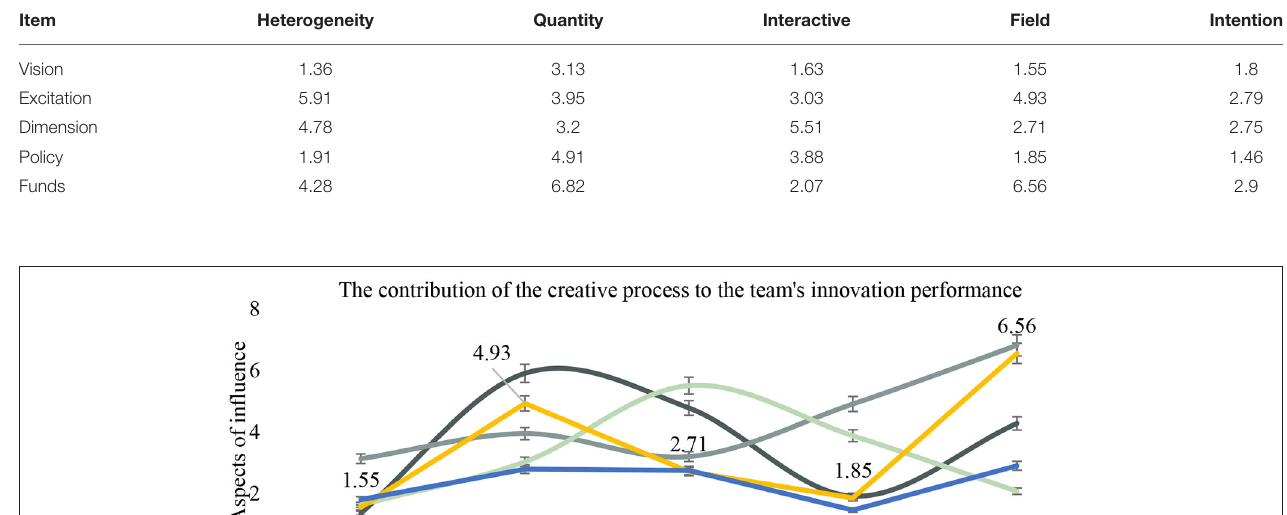
TABLE 8 | English team learning, team innovation, and entrepreneurship projects.